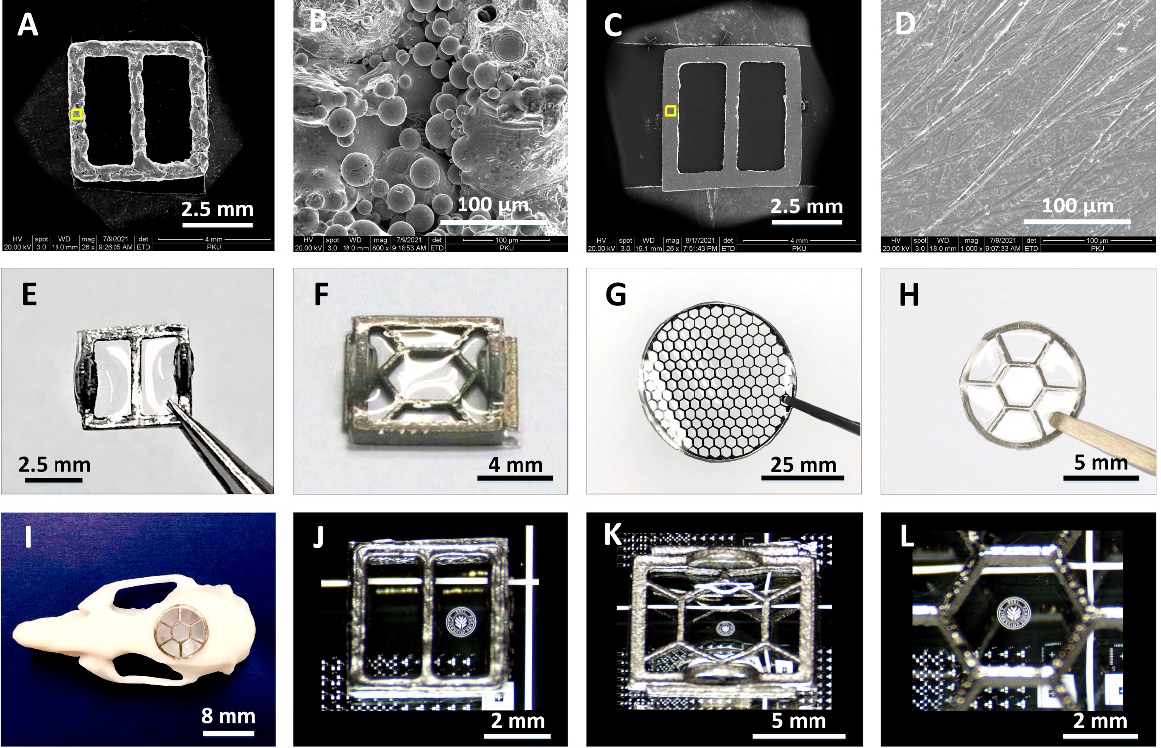
Figure 3. Images showing morphology and transparency of the Ti-PDMS cranial windows. ( A , B ) SEM images of the inner surface of as-fabricated Ti frame at different magnifications at ( A ) low and ( B ) high resolution. ( C , D ) SEM images of the sample after mechanical polishing process at different magnifications at ( C ) low and ( D ) high resolution. ( E – H ) Photographs of as-fabricated Ti-PDMS cranial windows, where a PDMS layer was mounted onto each polished Ti-frame. ( I ) Photograph of resin rat skull mold equipped with a curved Ti-PDMS cranial window. ( J – L ) Microscope images of the cranial windows in Figure ( E – G ), respectively, when they were placed on a silicon chip with a logo patterns.